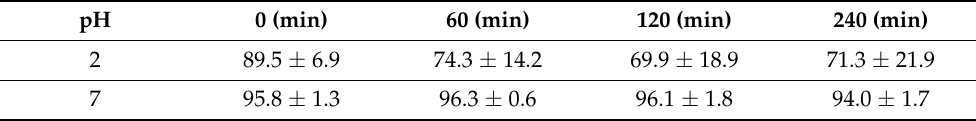
Table 3. Percentage (%) of in vitro bench stability as a function of time of [ 99m Tc]Tc-DPD-Fe 3 O 4 DMCAs initially prepared at two different pH values, namely at pH 2 and at pH 7, respectively. The results are expressed as mean value ± standard deviation of at least three independent experiments.